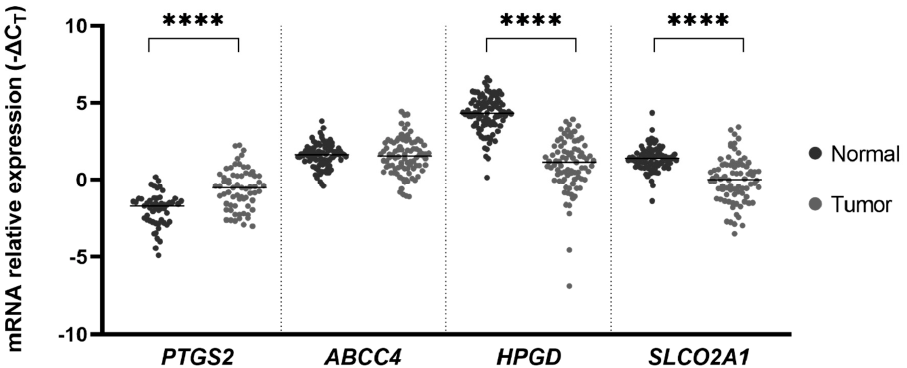
Figure 1. mRNA expression of the prostaglandin E 2 (PGE 2 ) pathway in gastric cancer (GC). prostaglandin-endoperoxide synthase 2 ( PTGS2) is upregulated in tumor samples compared to normal samples by a mean factor of 2.51, whereas hydroxyprostaglandin dehydrogenase 15-(NAD) ( HPGD ) and solute carrier organic anion transporter family member 2A1 ( SLCO2A1) are downregulated in tumorous mucosa by a mean factor of 0.10 and 0.37, respectively. Lines represent median values of expression. **** p < 0.0001.